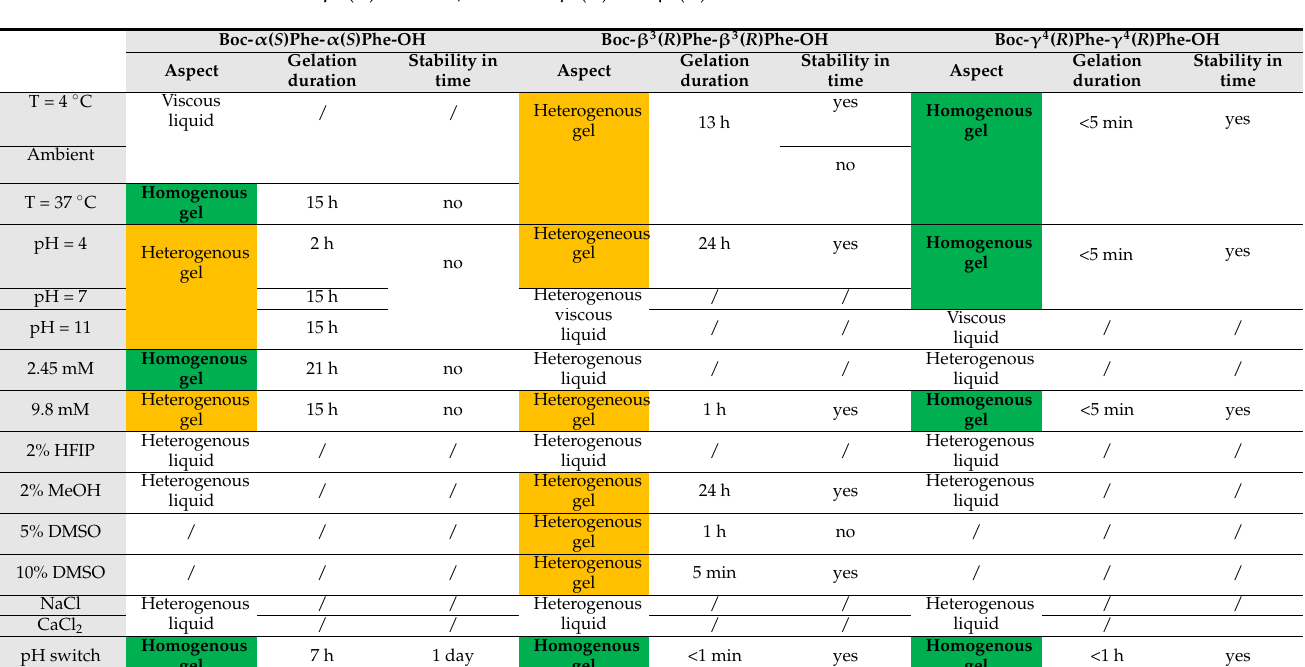
Table 1. Summary of the hydrogelation tests performed for Boc- α ( S )Phe- α ( S )Phe-OH, Boc- β 3 ( R